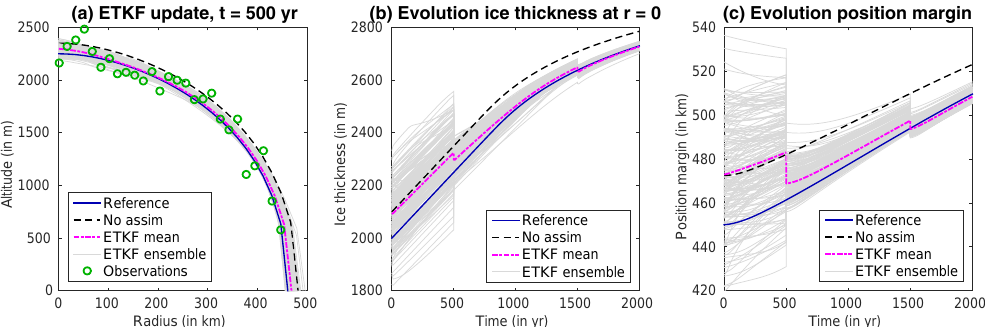
Figure 7. (a) ETKF analysis at time t = 500 years compared with the forecast and the reference. The ice thickness profile is improved over the whole domain and the reference profile is within the ensemble spread. (b) Evolution of the ice thickness at r = 0 with time. The estimates are of very good quality and the estimates seem to converge towards the reference value at the end of the study. (c) Evolution of the position of the margin with time. The ETKF provides consistent estimates and the reference value is always within the ensemble spread. Est. [corr] at t = 500 yr i,j